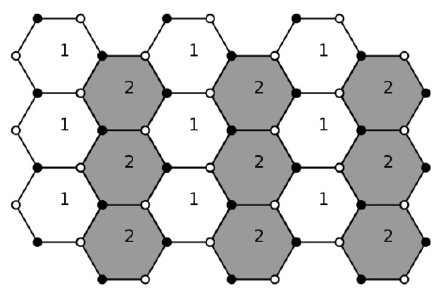
Figure 21 . The dimer of the C 2 = Z (cid:2) C singularity with its N = 2 fractional branes. 2 Geometrically, these branes correspond to D5-branes wrapping a non-trivial (col- lapsed) two-cycle of a CY 3-fold which locally looks like K 3 (cid:2) C , where C corresponds to the (cid:13)at direction the brane can freely move